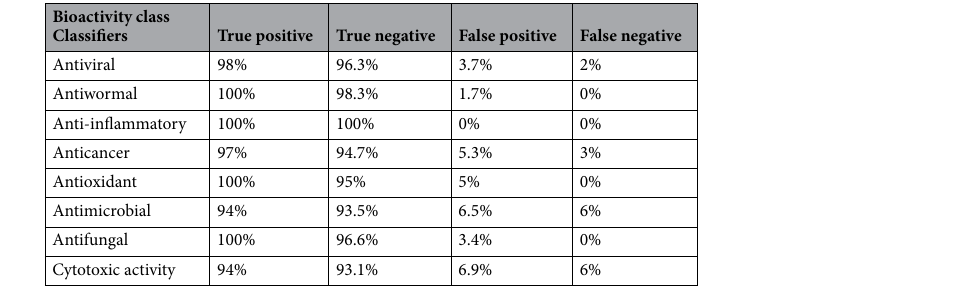
Table 3. The confusion matrix values for the predicting